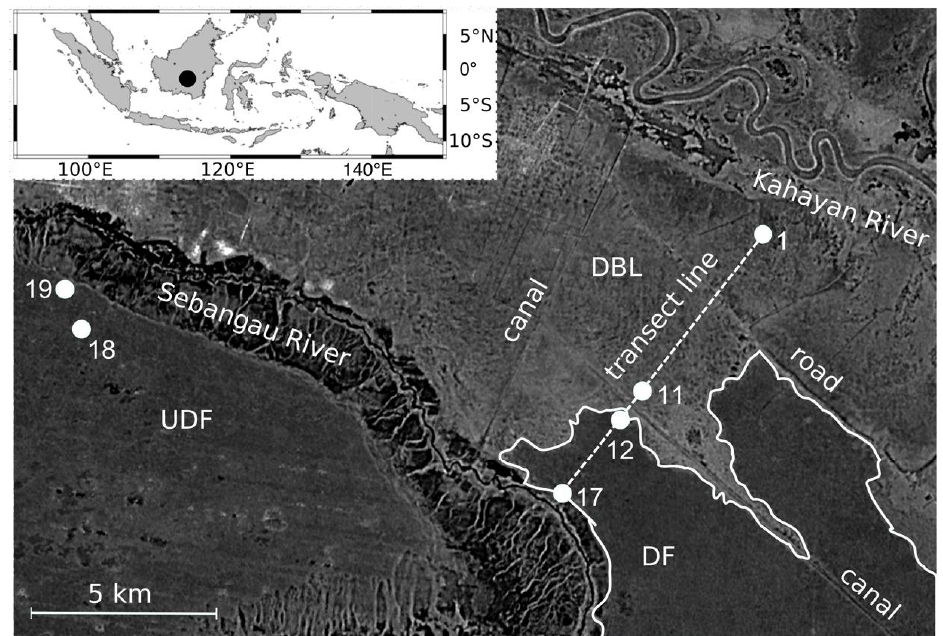
Figure 1. Map of the study site. The study site is located at the black circle of upper left map. Numbers beside the white circles denote plot ID. Plot ID of 1–11 attribute to drained burned land (DBL), 12–17 attribute to drained forest (DF) that was surrounded by the white solid line, and 18–19 attribute to undrained forest (UDF) that was southwest of Sebangau River. Not all plots are shown due to visibility.